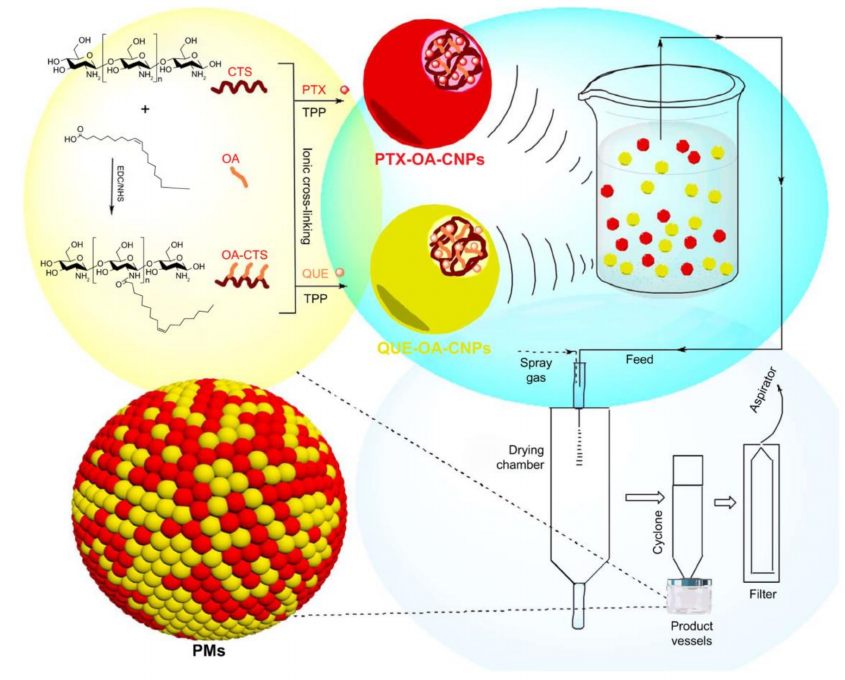
Figure 1. Synthesis and preparation scheme of PMs (PMs, polymeric microspheres; CTS, chitosan; OA, oleic acid; OA-CTS, OA-conjugated CTS; EDC, 1-(3-dimethylaminopropyl)-3-ethylcarbodiimide hydrochloride; NHS, N -hydroxysuccinimide; PTX, paclitaxel; TPP, sodium tripolyphosphate; QUE, quercetin; PTX-OA-CNPs, nanoparticles loaded with PTX; QUE-OACNPs, nanoparticles loaded with QUE); reproduced with the permission from [59], Copyright (2017) DOVE Medical